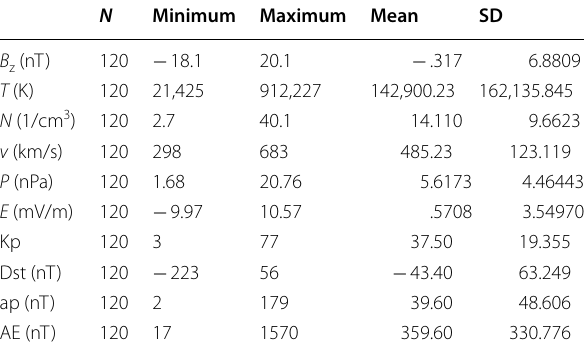
Table 2 Pearson’s correlation matrix for the storm variables